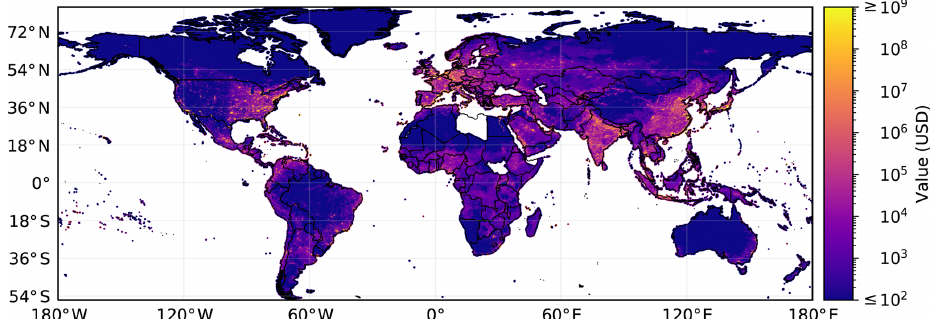
Figure 2. World map showing gridded asset exposure values scaled to a resolution of 600arcsec. The actual resolution of the underlying gridded data is 30arcsec ( ∼ 1km). To obtain this dataset, national total asset values were disaggregated proportional to the distribution of Lit 1 Pop 1 for 224 countries and areas. A total of 26 countries and areas without data are left blank, including Libya, South Sudan, and Syria. The color map is logarithmic and limited to USD100 (lower bound) and USD1000000000 (upper bound). Borders and coast lines are based on Cartopy (Met Office,